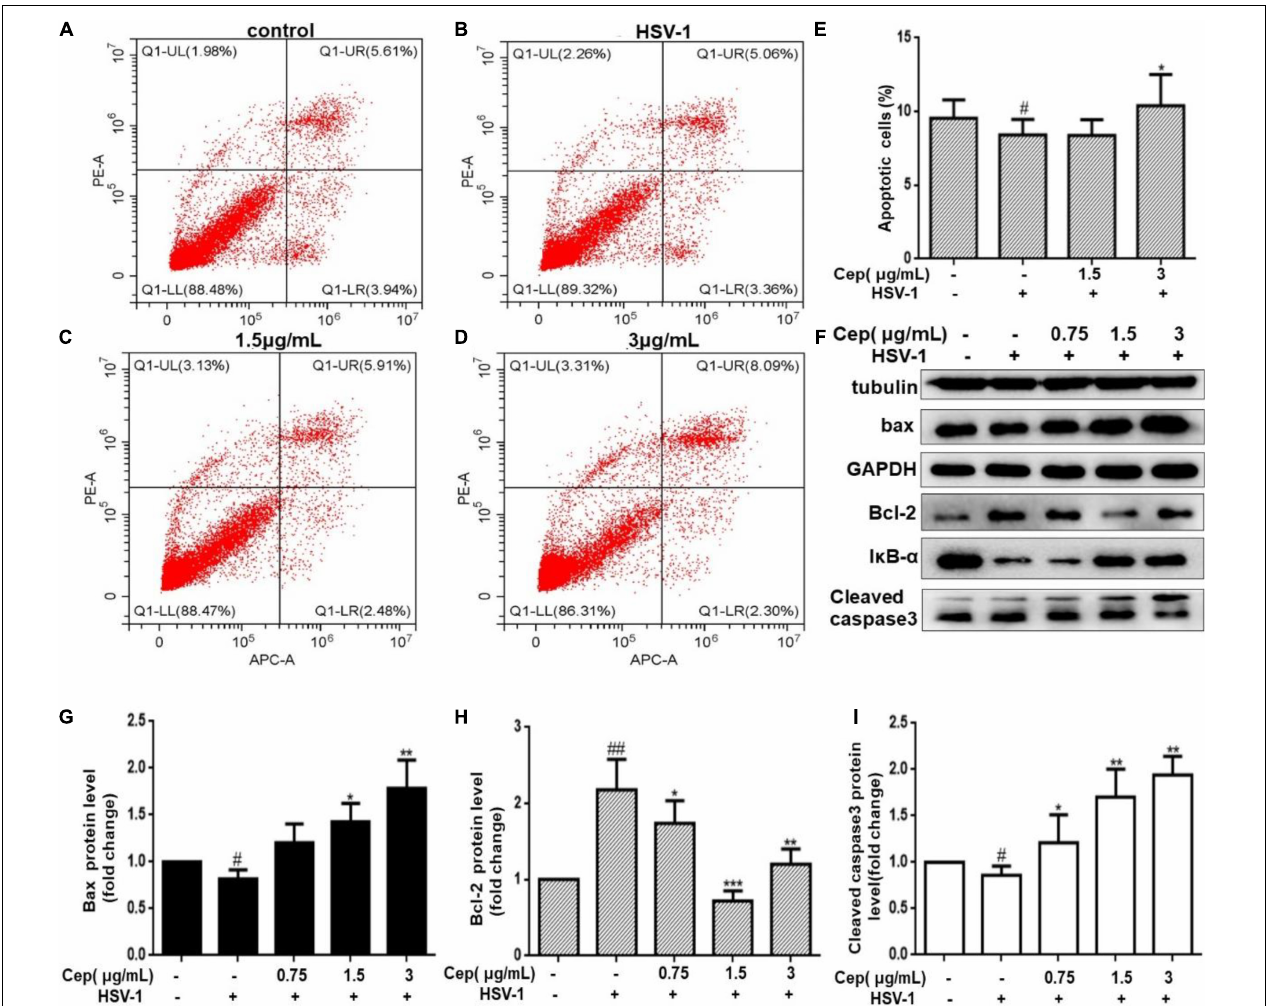
FIGURE 7 | The effect of CEP on the cell apoptosis of infected cells. (A–D) HSV-1 (MOI = 1) infected Hela cells were treated with CEP (3 and 1.5 µ g/mL) for 36 h. Cells were collected, and cell apoptosis was analyzed by flow cytometry; LL (lower left) represents viable cells (%), UL (upper left) represents necrotic cells (%), LR (lower right) represents early apoptotic cells (%), UR (upper right) represents late apoptotic cells (%). (E) Percentages of apoptotic cells in CEP-treated Hela (LR%+UR%). # P < 0.05 indicates significant difference vs. NC group; * P < 0.05 indicates significant difference vs. model group. (F) Hela cells in six-well plates were infected with HSV-1 (MOI = 1) in the presence of the CEP at different concentrations, including 0.75, 1.5, and 3 µ g/mL for 36 h. Cell lysates were collected for Western blotting as indicated. (G–I) Results from three independent experiments were quantitated and presented as means ± SD. # P < 0.05; ## P < 0.01 indicates significant difference vs. NC group; * P < 0.05; ** P < 0.01; *** P < 0.001 indicates significant difference vs. model